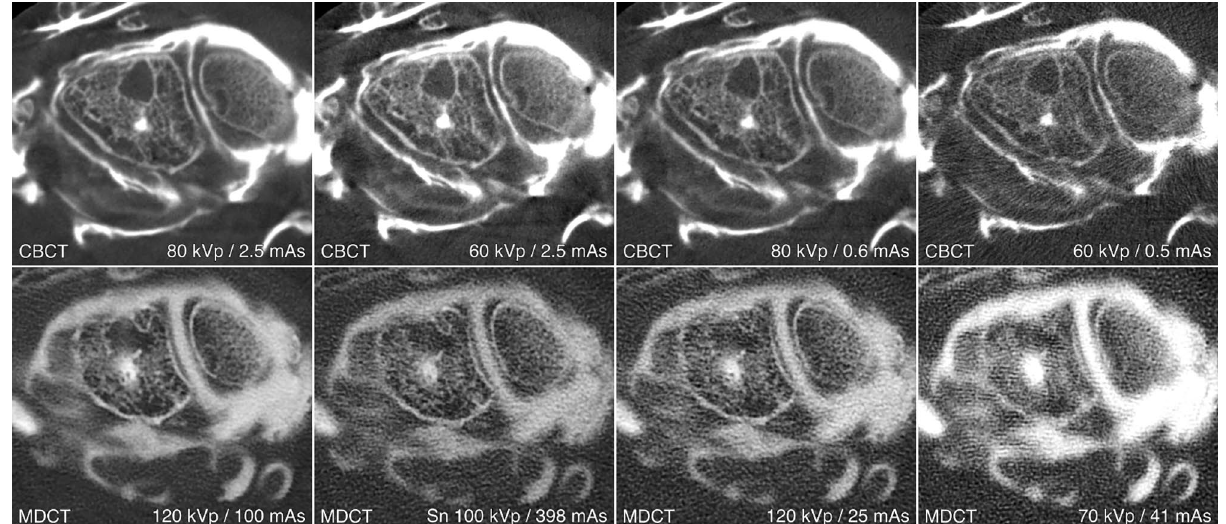
Figure 5. Axial views of the same cadaveric specimen depict the torn dorsal portion of the scapholunate ligament, which functions as the primary stabilizer of the proximal carpal row. While increased articular distension over time was helpful for ligament analysis in multidetector CT (MDCT; lower row), the detailed visualization of bone microarchitecture in cone-beam CT (CBCT; upper row) allowed for superior depiction of a ganglion cyst within the lunate bone. Bone/cartilage/ligaments